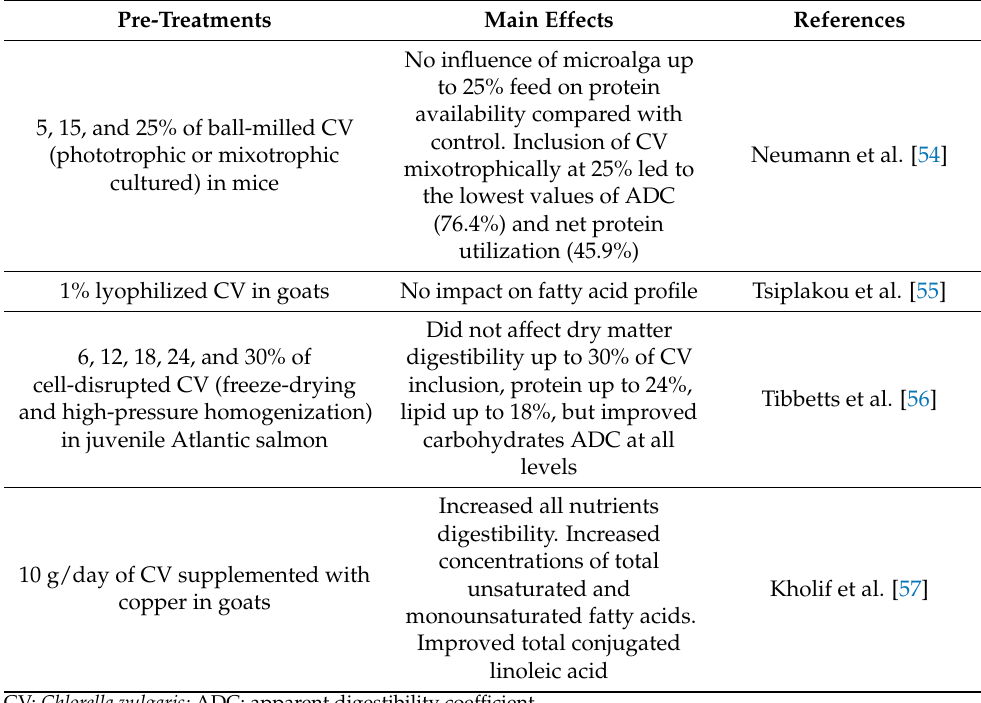
Table 3. Summary of the main effects of pre-treatments combined with in vivo trials on hydrolysis and digestibility of Chlorella vulgaris (CV)